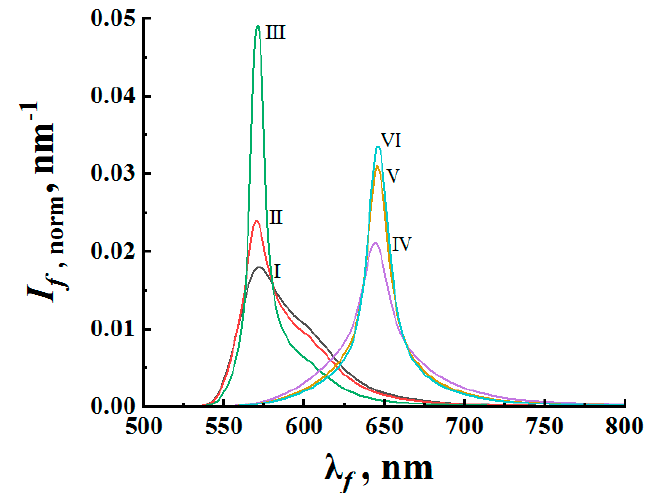
Figure 2. Evolution of the normalized fluorescence spectra with an increase in the pump intensity. I – III – R6G-doped samples #1; VI – VI – DCM-doped samples #1. I p ≈ 1.0 × 10 6 W/cm 2 (I); 1.3 × 10 7 W/cm 2 (II); 3.9 × 10 7 W/cm 2 (III); 2.2 × 10 7 W/cm 2 (IV); 1.0 × 10 8 W/cm 2 (V); 1.4 × 10 8 W/cm 2 (VI).